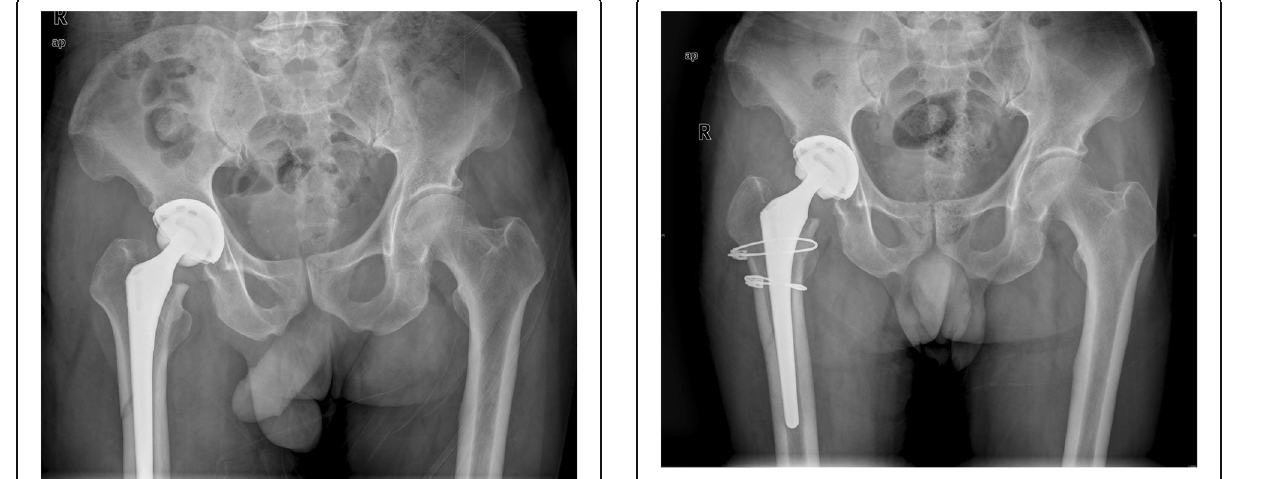
Fig. 3 Anteroposterior radiograph 2 years after ORIF showed reduction and fixation of the fracture, the fracture healed well, and the stem is